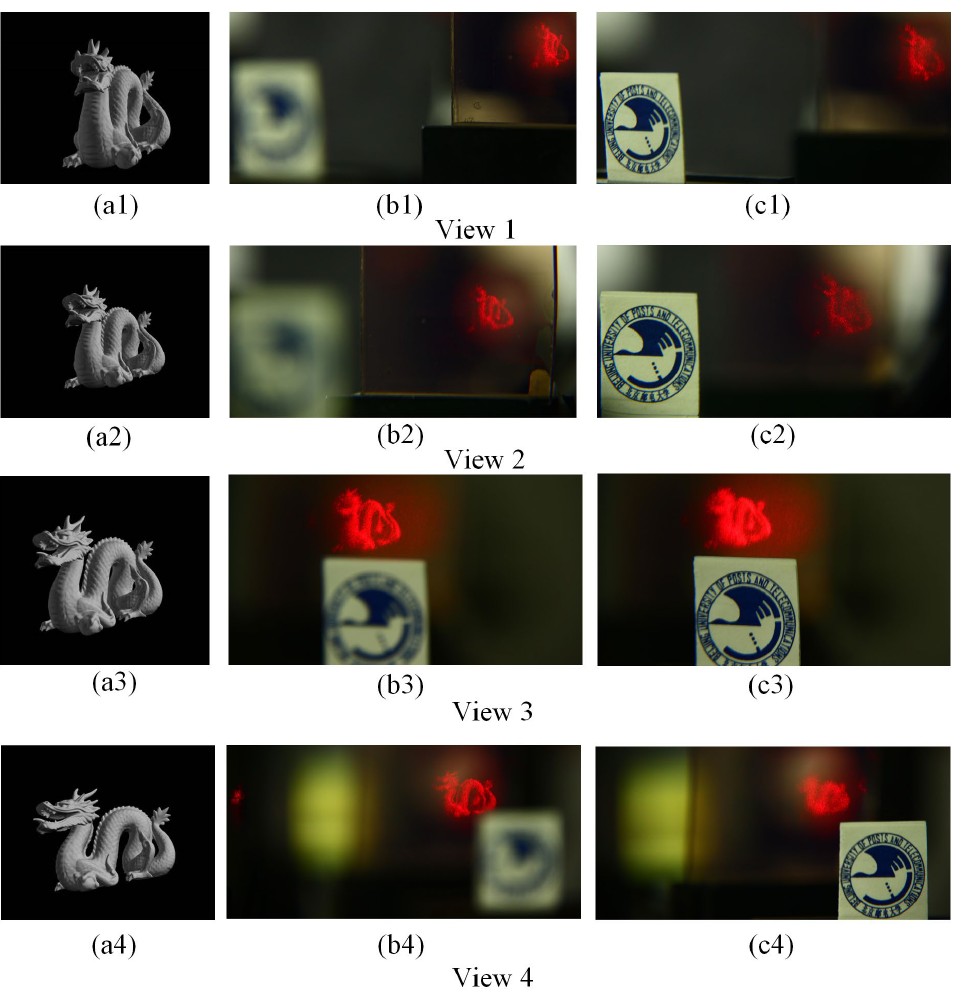
Figure 10. ( a1 ) The image of view 1. The captured reconstructed image of view 1 ( b1 ) the camera focused on the tail ( c1 ) the camera focused on the emblem of the BUPT ( a2 ) The image of view 2. The captured reconstructed image of view 2 ( b2 ) the camera focused on the tail ( c2 ) the camera focused on the emblem of the BUPT ( a3 ) The image of view 3. The captured reconstructed image of view 3 ( b3 ) the camera focused on the tail ( c3 ) the camera focused on the emblem of the BUPT ( a4 ) The image of view 4. The captured reconstructed image of view 4 ( b4 ) the camera focused on the tail ( c4 ) the camera focused on the emblem of the BUPT.